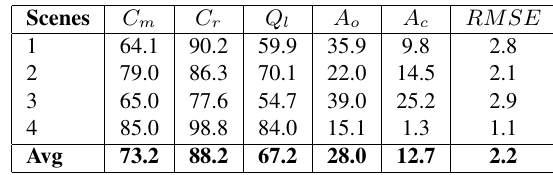
Table 7: Pixel-based evaluation results for September data set for the generated map from the automatically extracted buildings.